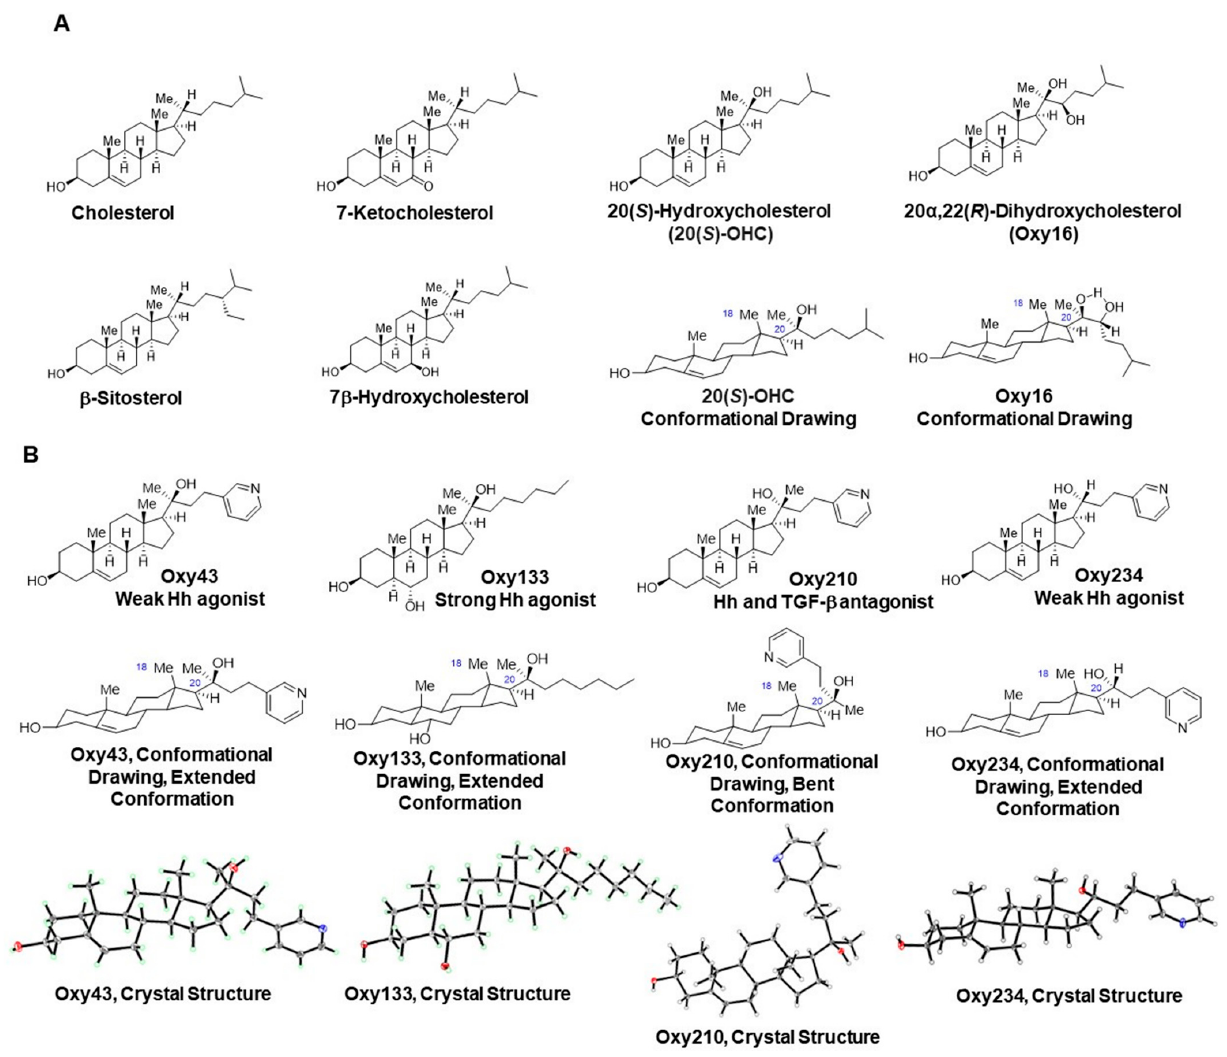
Figure 5. ( A ) Molecular structures of naturally occurring sterols and oxysterols. Cholesterol, β -sitosterol, 7-ketocholesterol, 7 β -hydroxycholesterol, 20( S )-hydroxycholesterol (20( S )-OHC), and 20 α ,22( R )-dihydroxycholesterol (Oxy16). Conformational drawings of 20( S )-OHC and Oxy16 are based on crystal structures. ( B ) Molecular structures, conformational drawings, and crystal structures of semi-synthetic oxysterols Oxy43, Oxy133, Oxy210, and Oxy234.